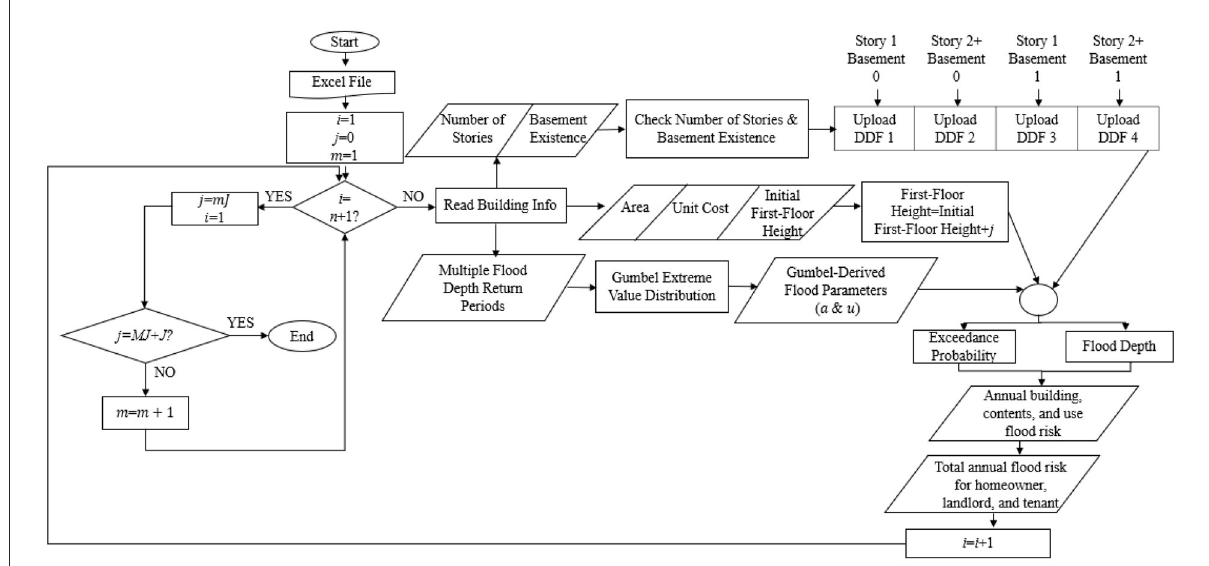
FIGURE1 General outline of the research framework, for homes (i to n), targeted elevation (j) at each step, constant increment by which the elevation increases (J) for each step, number of steps (M), and final targeted elevation